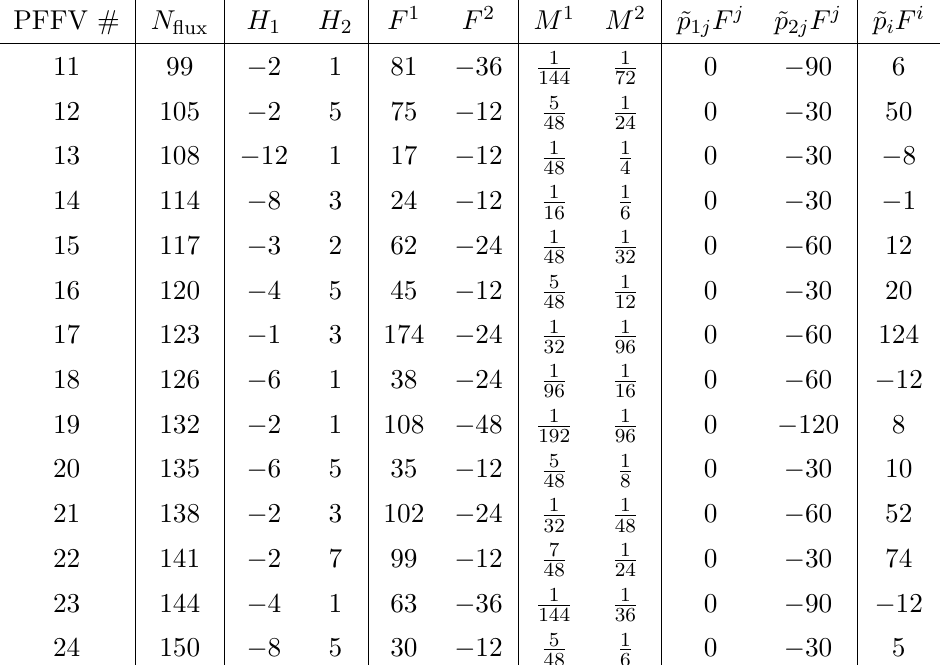
Table 1. Details of 24 PFFV obtained after Step S3, and by demanding 0 < N flux ≤ 150